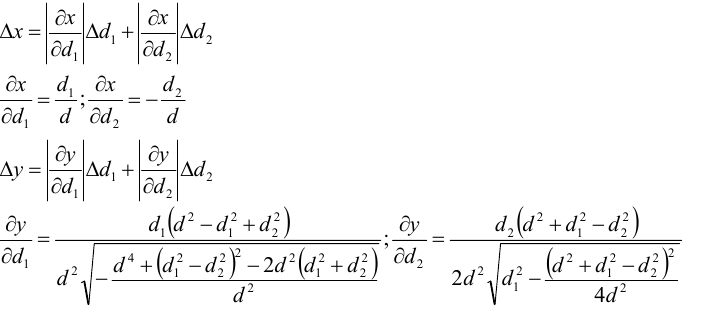
Figure 7. Localization error as a function of Cartesian